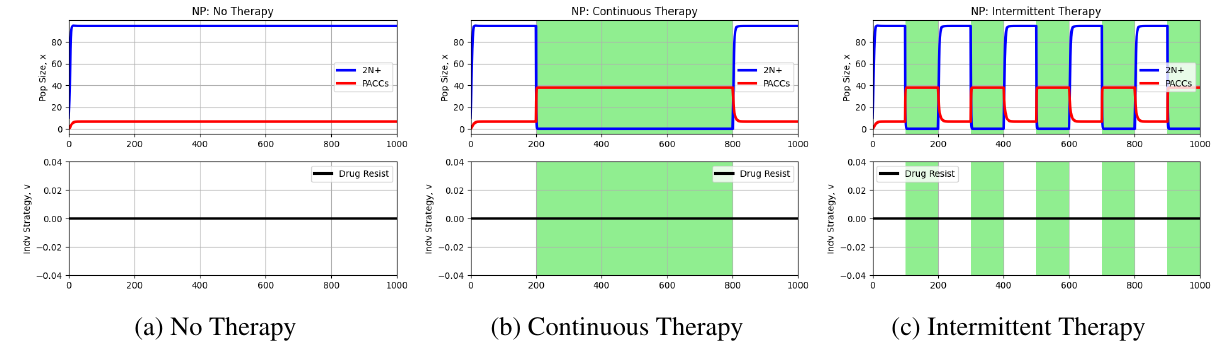
Figure 2. Simulations under non-proliferation hypothesis. Blue and red curves depict 2N+ and PACC population dynamics, respectively, and the black curve captures the evolutionary dynamics of resistance. White and green backgrounds reflect periods without and periods with treatment, respectively. During times of treatment, the population is able to persist by entirely existing in the PACC state. During drug holidays, the cells switch to a predominantly 2N+ state. Since PACCs are not killed by therapy, the selection gradient with respect to drug resistance is zero and hence, resistance does not